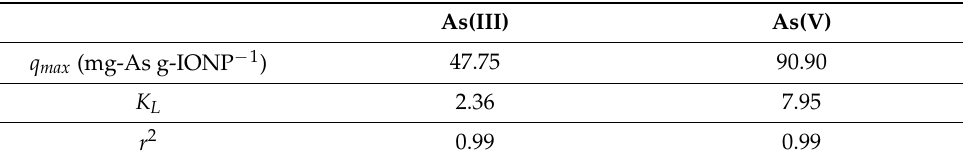
Table 2. Summary of Langmuir isotherm model fits for arsenic adsorption onto the CNF-IONP aerogel.